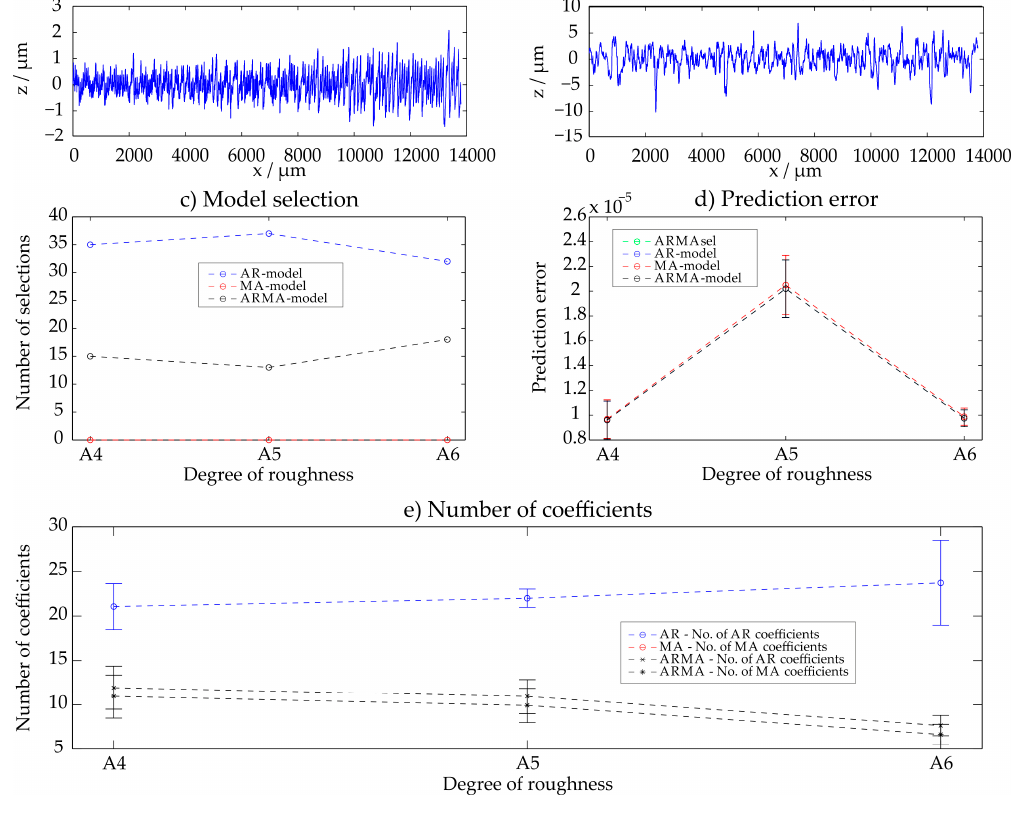
Figure 4. Reaming—results with the ARMAsel-algorithm.